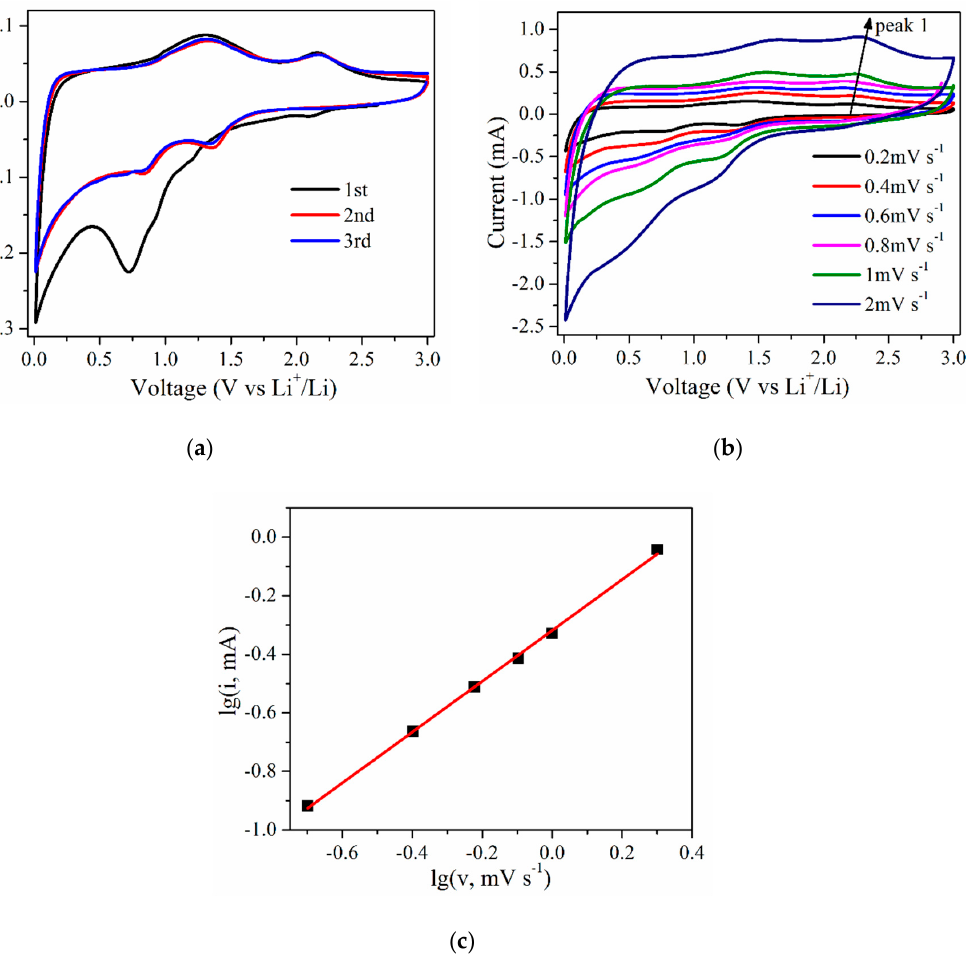
Figure 6. Cyclic voltammetry (CV) behavior of the Co 3 O 4 /AG nanocomposite: ( a ) CV curves at 0.1 mV · s − 1 , ( b ) CV curves at various scan rates from 0.2 to 2 mV · s − 1 , and ( c ) the relationship between the anodic peak current at around 2.20 V and the scan rate.